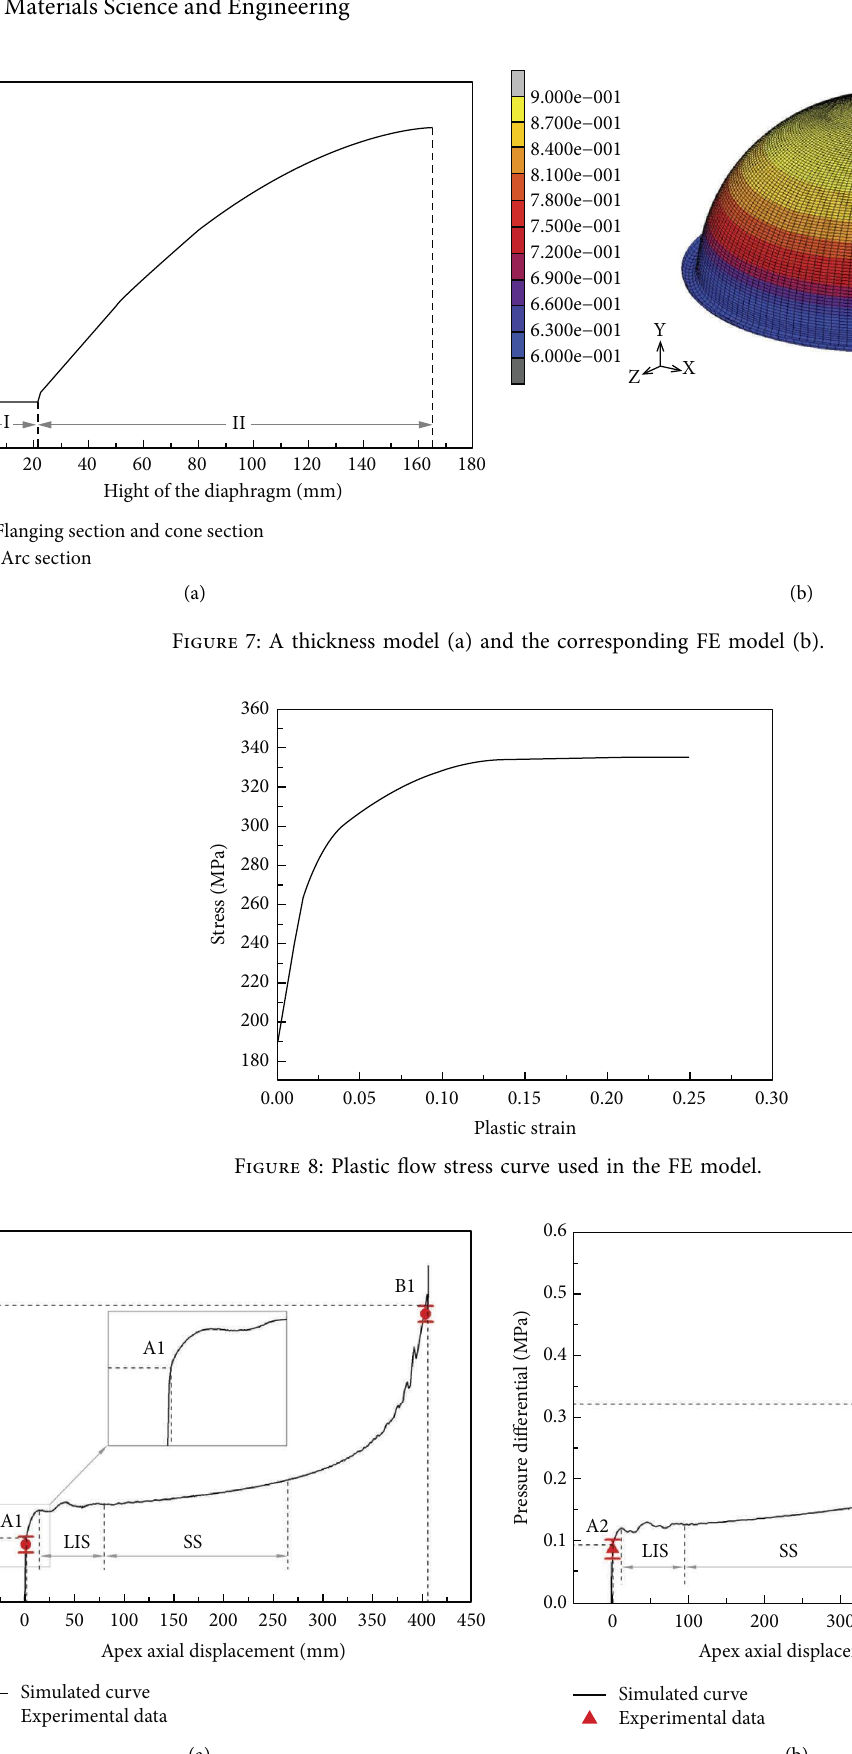
Figure 9: Relationships of pressure diferential and apex axial displacement of the diaphragms. (a) Serial number E1, (b) Serial number